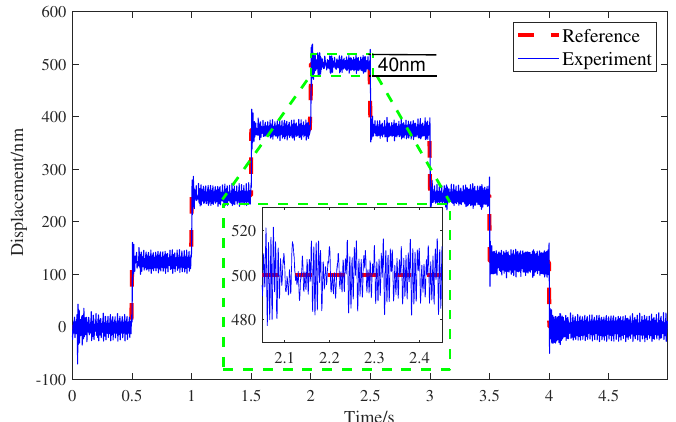
Figure 17. Experiment results for staircase signal